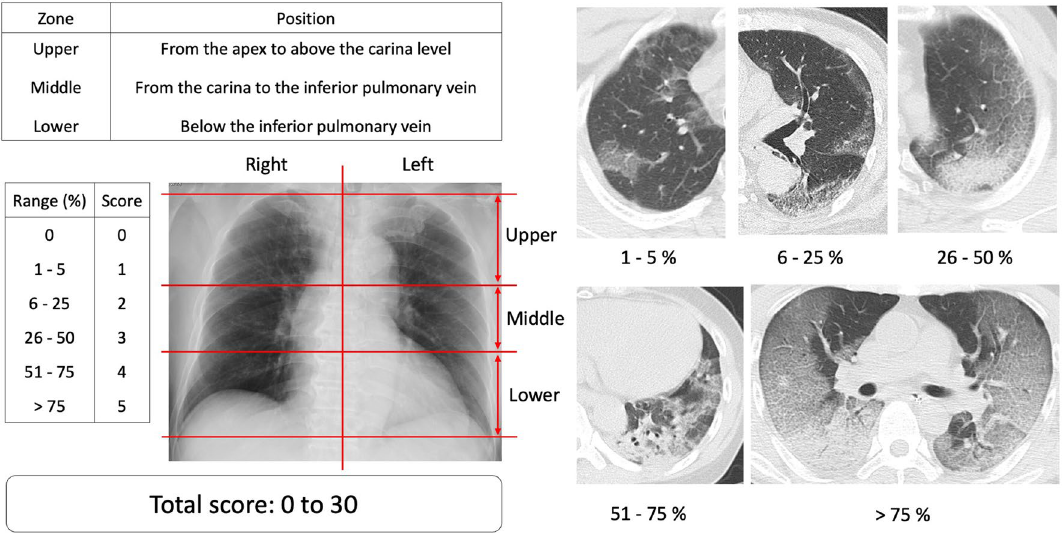
Figure 1. CT scores and axial images by lung zone involvement in COVID-19 pneumonia. The lung area was divided into three zones from the apex to bottom. The upper lung zone extended from the pulmonary apex to the bronchial bifurcation, the middle from the bronchial bifurcation to the right inferior pulmonary vein, and the lower from the right inferior pulmonary vein to the